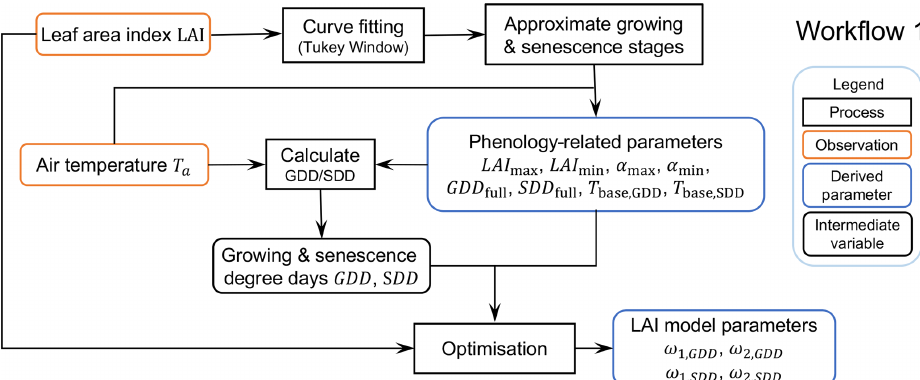
Figure 3. Workflow 1 (Fig. 1) for deriving LAI- and albedo-related parameters. Related Jupyter notebooks are provided in Sun et al. (2021).